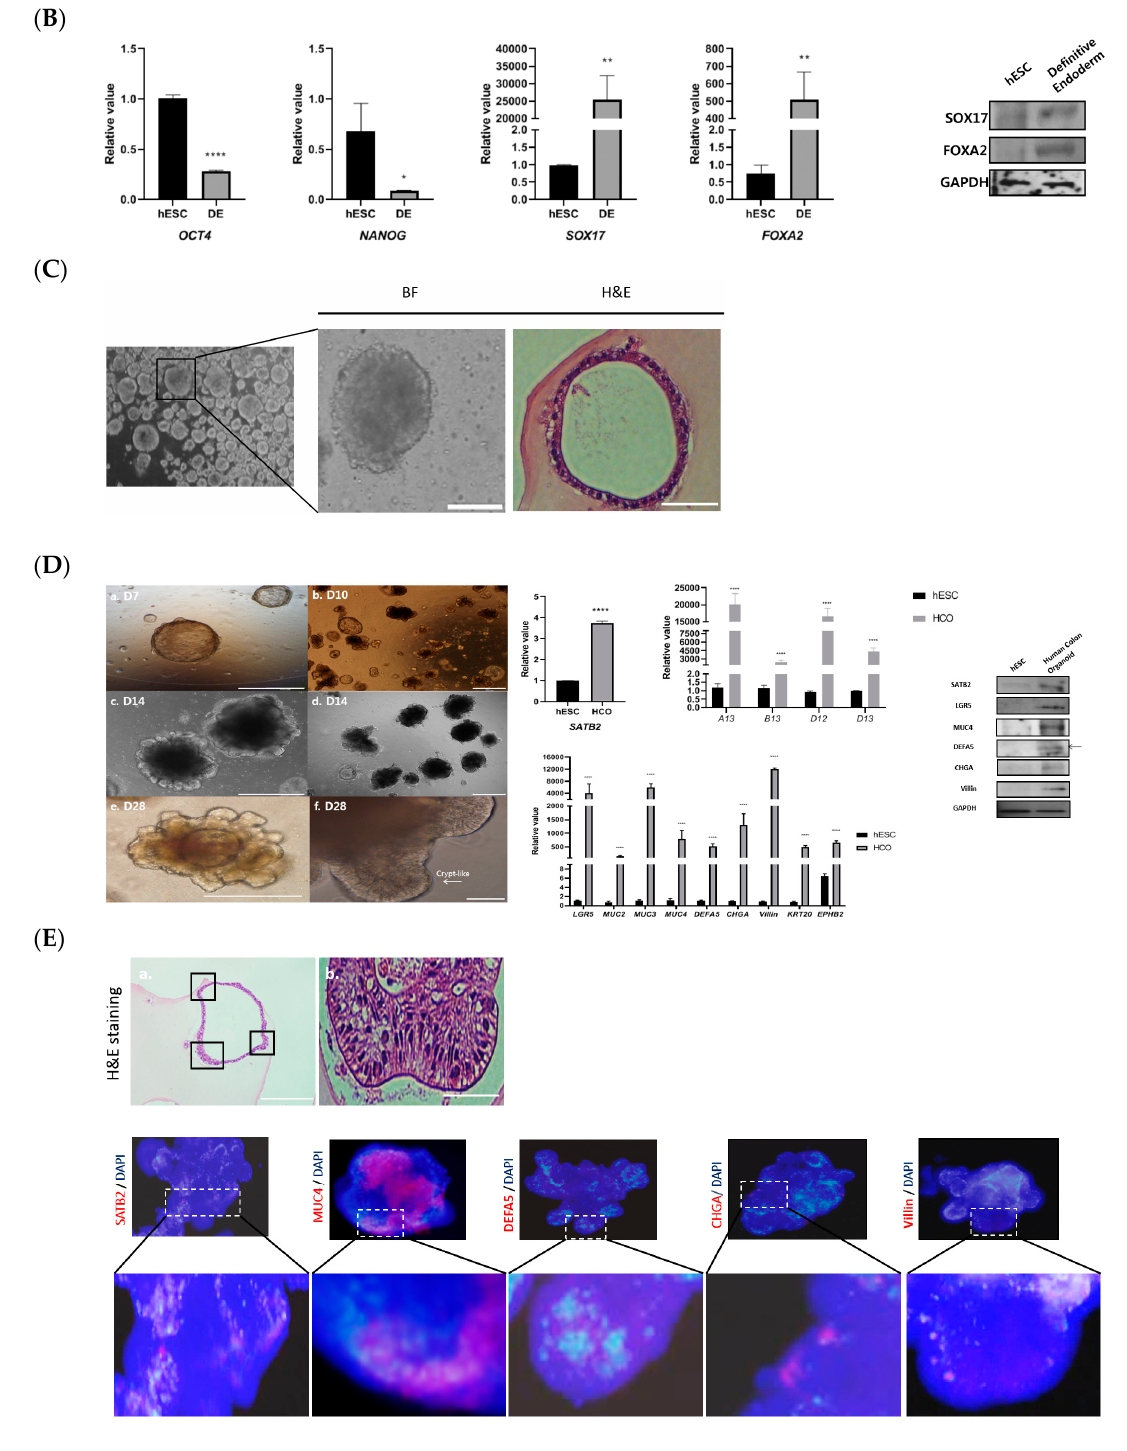
Figure 2. Development and characterization of HCOs. ( A ) HCO differentiation protocol. ( B ) Expression of pluripotency markers ( OCT4 and NANOG ) and endoderm differentiation markers ( SOX17 and FOXA2 ) in the definitive endoderm (DE) of HCOs and untreated hESCs as detected via qRT ‐ PCR. SOX17 and FOXA2 expression was detected by Western blotting, with GAPDH used as a loading control. ( C ) Hindgut (HG) morphology on bright ‐ field (BF) microscopy and H&E staining. Expression of hindgut markers ( CDX2 and KLF5 ) as detected via qRT ‐ PCR. ( D ) Development of morphologic changes in HCOs over time. Crypt ‐ like structures had formed by day 28. Expression of colon ‐ specific marker ( SATB2 ); posterior HOX markers ( HOXA13 , HOXB13 , HOXD12 , and HOXD13 ); adult stem cell marker ( LGR5 ); goblet cell markers ( MUC2 , MUC3 , and MUC4 ); and markers for paneth cells ( DEFA5 ), enteroendocrine cells ( CHGA ), and enterocytes ( villin ) by HCOs as detected via